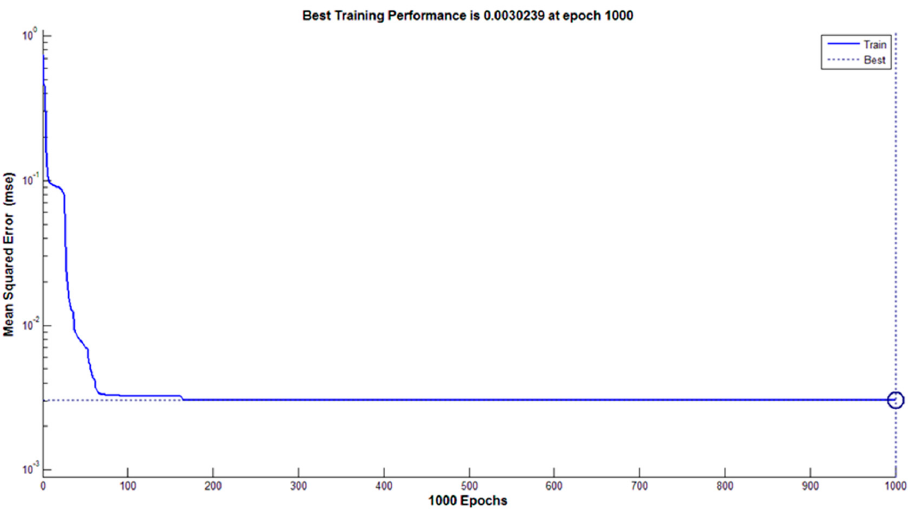
Figure 18. The curve of how to train a designed neural network to identify and classify. Brown rice cultivars.